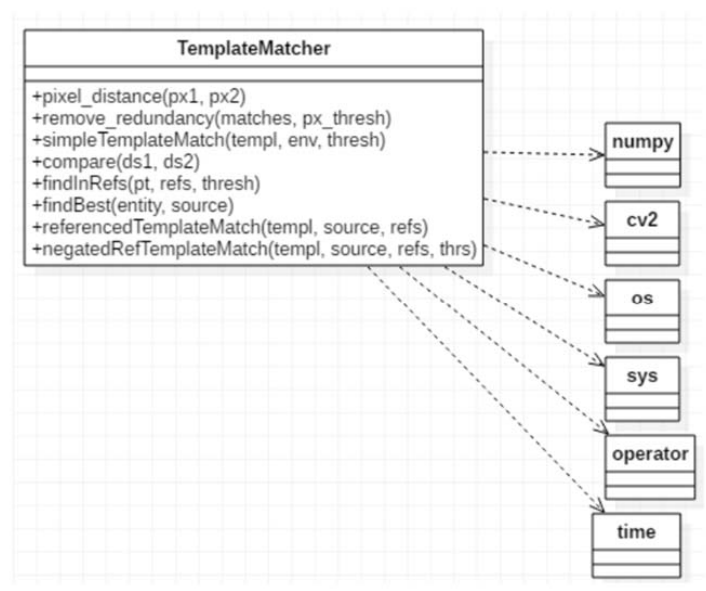
Figure 11. Class diagram of the Template Matcher module.